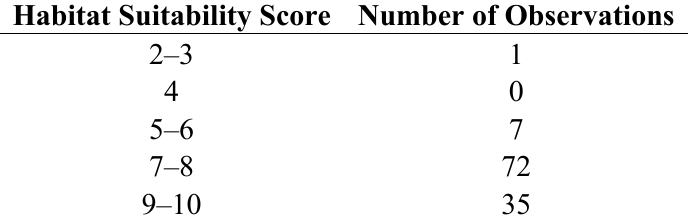
Table 4. Frequency distribution of existing Blanding’s Turtle observations in the study area with respect to wetland habitat suitability score. Each observation was matched to the closest wetland within a 250 m